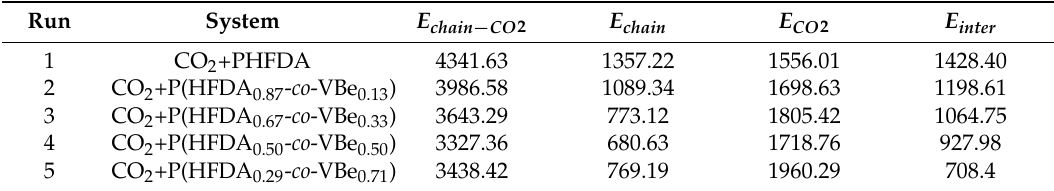
Table 3. Absolute value of the interaction energy between polymer chains and CO 2 at 308.2 K and 25 MPa (energy unit: kJ/mol).